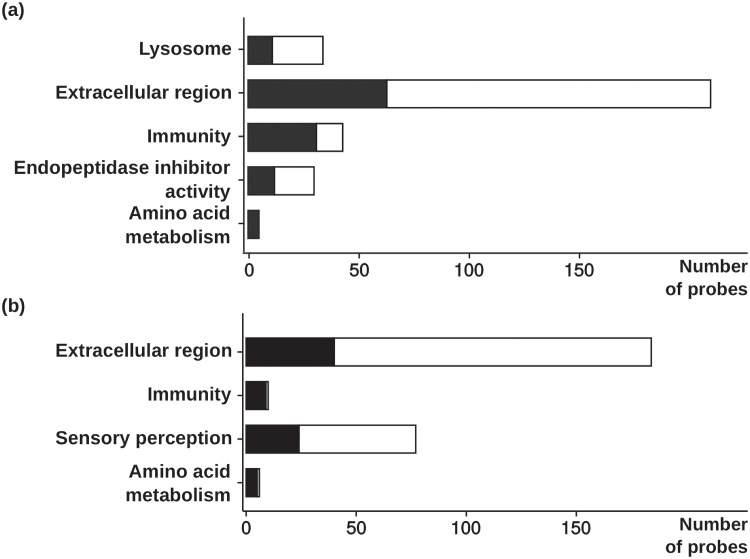
Gene ontology enrichment analysis results.Cluster with number of genes up (in black) and down-regulated (in white), issued from the gene ontology enrichment analysis using DAVID bioinformatics resource for the (a) R23h versus AB1h and (b) R23h versus A22h comparisons (Cut-off: p-value<0.01; Benjamini<0.1).